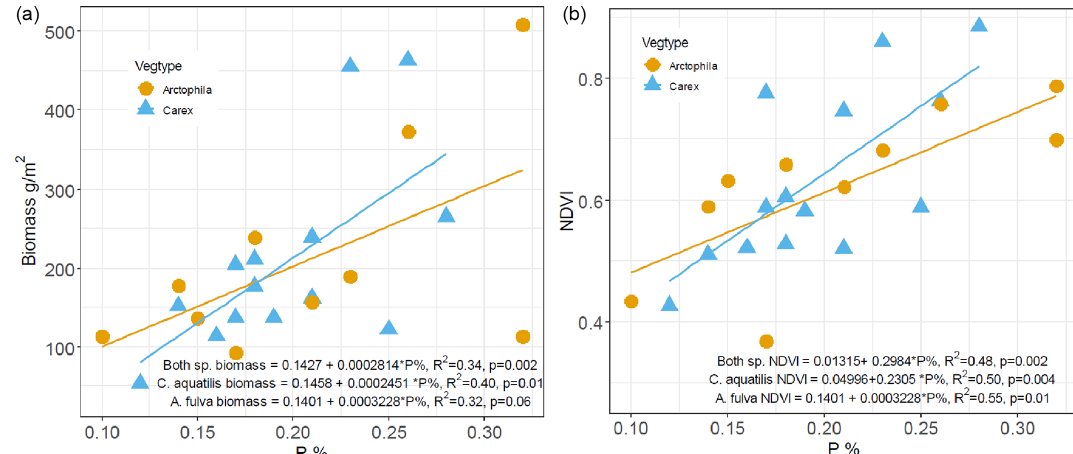
Figure 3. Relationship between phosphorus content (%) of leaves and dry weight aboveground biomass (a) and NDVI (b) for Carex aquatilis and Arctophila fulva . Biomass collected during peak growing season (first week of August). Each point represents site averages.